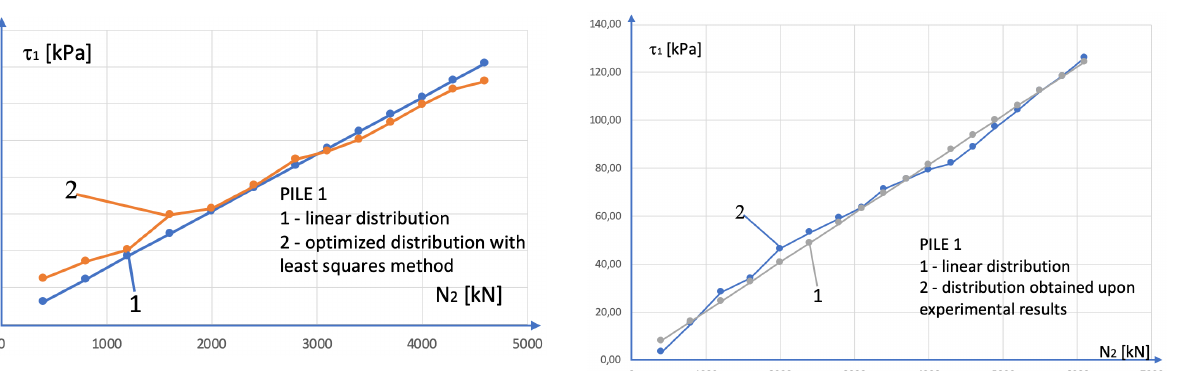
Figure 9a: Pile 1 values comparison; linear distribution for B